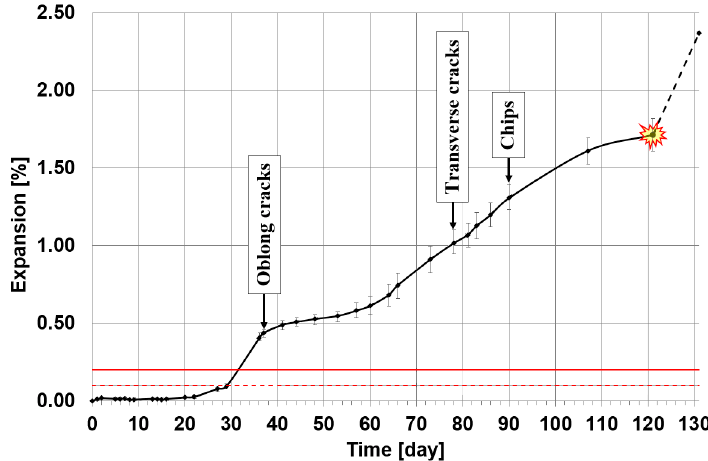
Figure 1. Expansion in the mortar with waste glass measured according to the ASTM C 1260 standard [38]. Measurement from 3 specimens until day 121 and measurement from 1 specimen conducted between day 121 and 131.